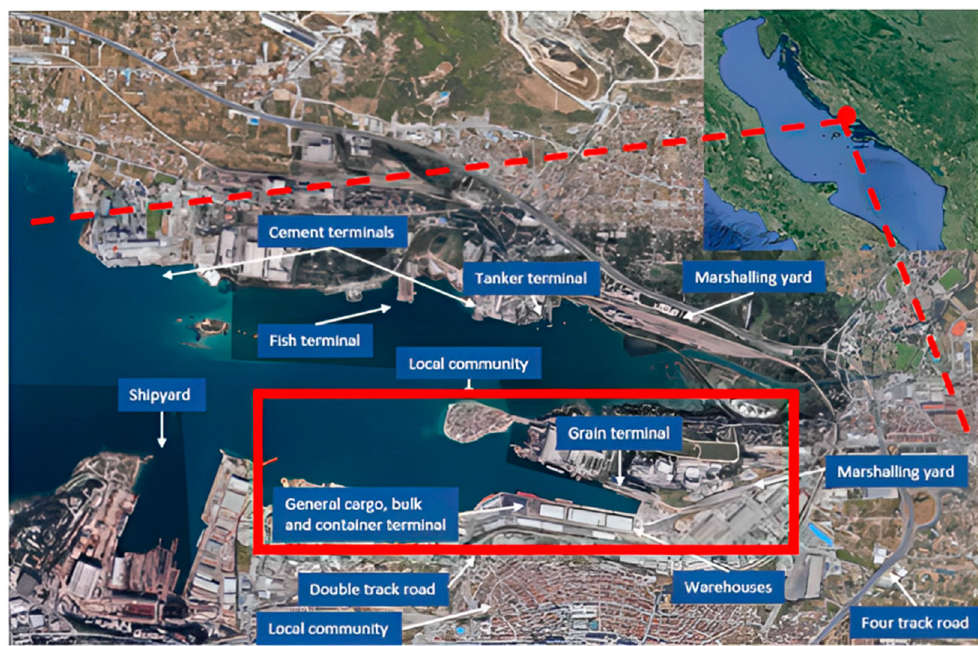
Figure 2. Overview of the cargo basin and infrastructure with indication of its functions ([46],